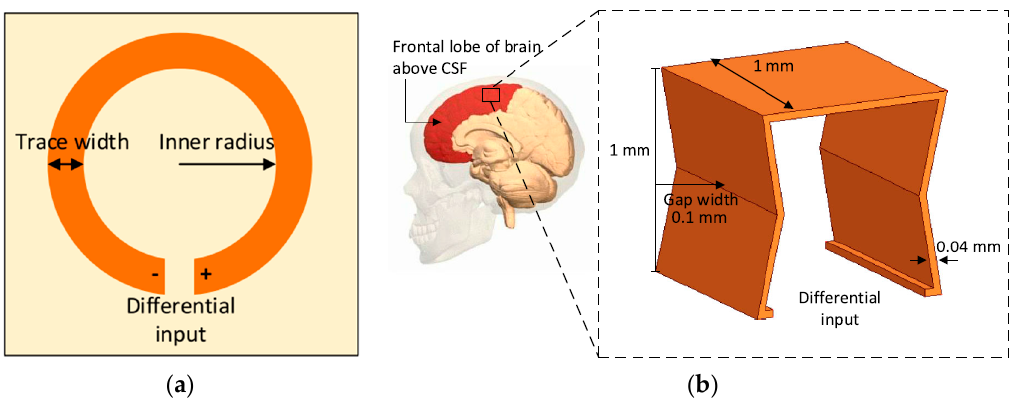
Figure 8. Geometry of the proposed NRIC WPT link [106]. ( a ) TX coil printed on FR4 board. ( b ) RX three-dimensional (3D) antenna embedded in the cerebral spinal fluid (CSF) above the frontal lope of the brain. Copyright © 2018, IEEE.